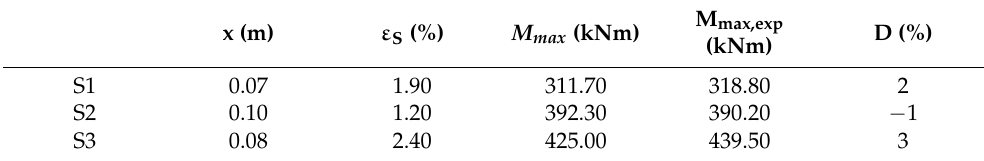
Table 4. Estimated and experimental peak bending